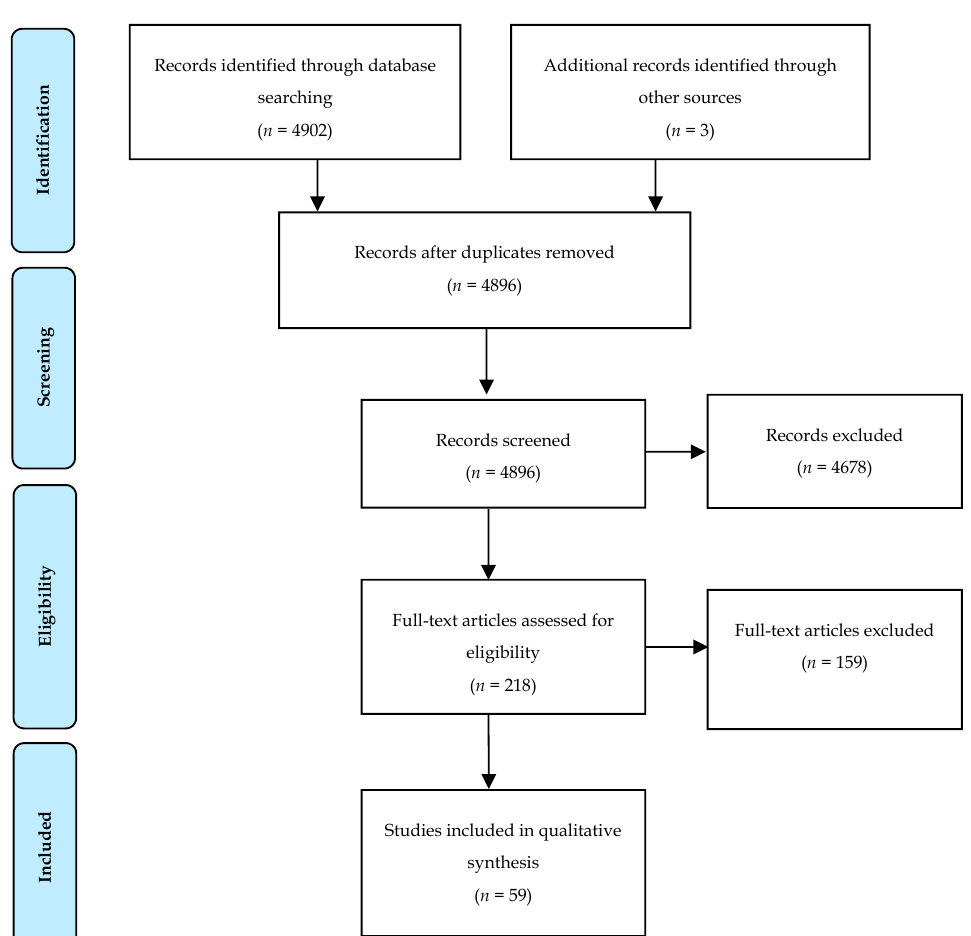
Figure 1. Flow diagram of the systematic search according to PRISMA [16].